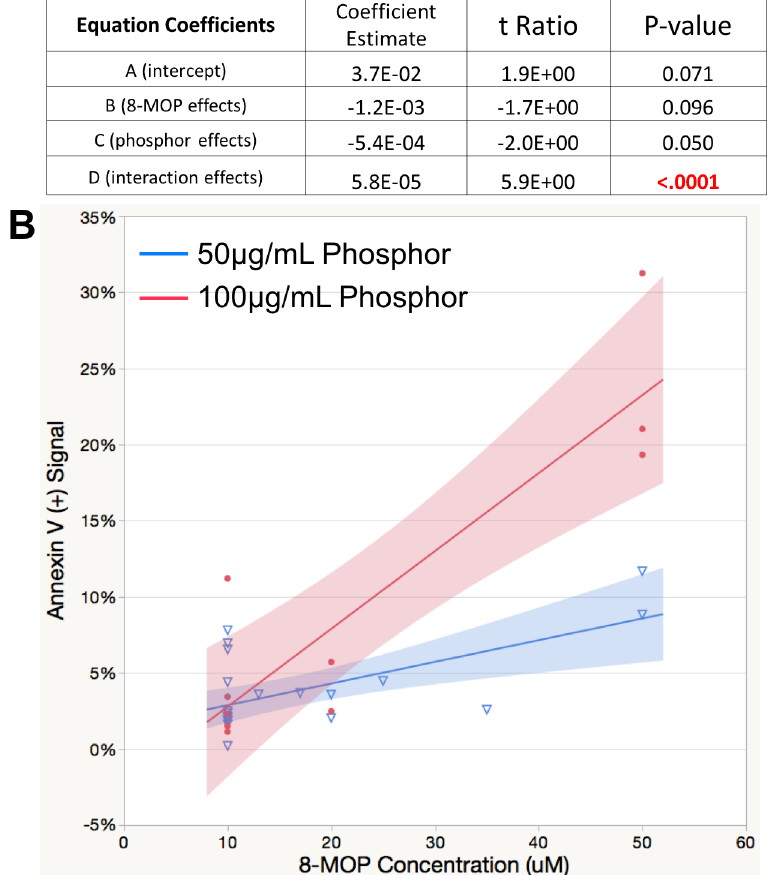
Fig 4. A : A multivariable linear regression analysis on 36 independent measurements of Annexin V (+) in 4T1-Her2 cells as a function of psoralen and phosphor concentration. All samples received an x-ray dose of 1 Gy at 80 kVp. Psoralen and phosphor concentrations ranged from 10 μ M to 50 μ M and from 25 μ g to 200 μ g respectively. The statistically significant interaction indicates that the effect of phosphor dose on Annexin levels is not consistent across levels of MOP. B: . graphically displays the regression model provided in 4A. The blue and red lines are the regression of psoralen on annexin when phosphor = 50 μ g/mL, and 100 μ g/mL respectively. The shaded regions indicate the 95% confidence